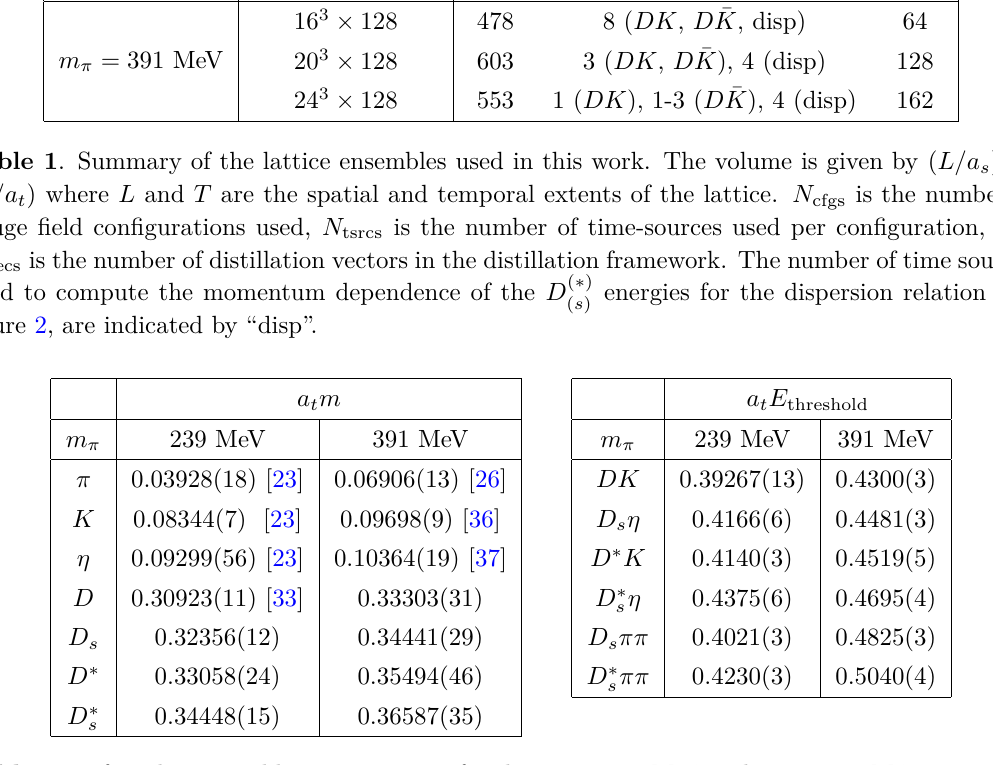
Table 2 . Left: relevant stable meson masses for the m π = 239 MeV and m π = 391 MeV ensembles from dispersion fits. Right: relevant kinematic